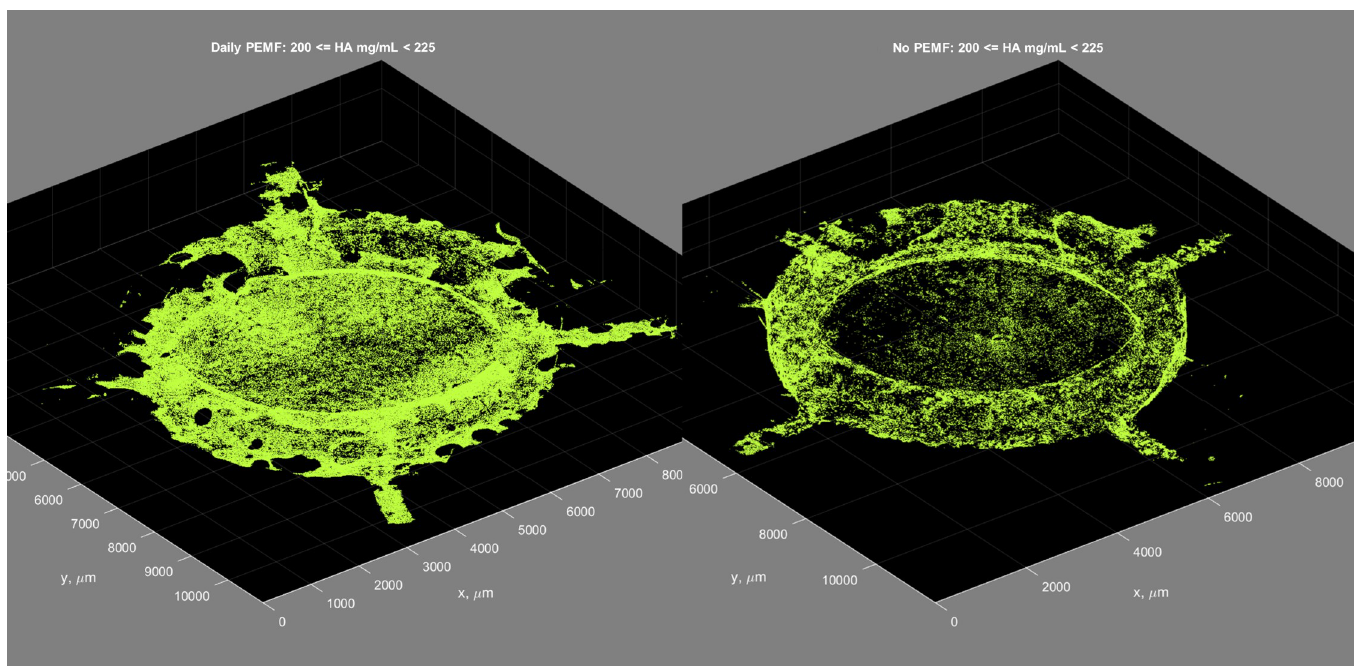
Fig 8. Micro-CT-derived 3D distribution of voxels in the density range maximally influenced by PEMF on Day 63. Constructs treated with Daily PEMF (left panel) and no-PEMF controls (right panel). The density range presented is 200–225 HA mg/ml.